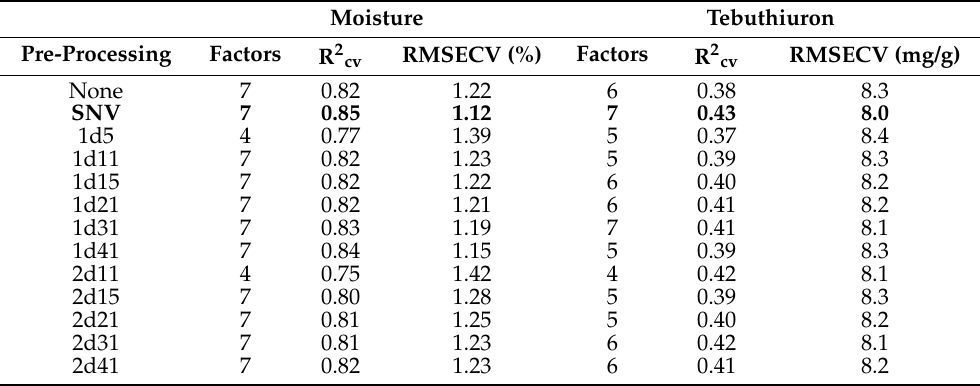
Table 6. Optimum pre-processing methods for the prediction of moisture and tebuthiuron content in powdered Regain samples using FTIR spectroscopy. The best-performing model for each analyte is highlighted in